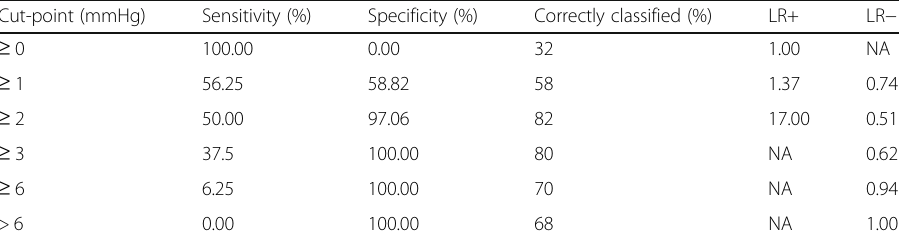
Table 4 Performance of Δ ET-CO2 post-PLR against Δ CO ≥ 12% for the prediction of volume responsiveness Cut-point